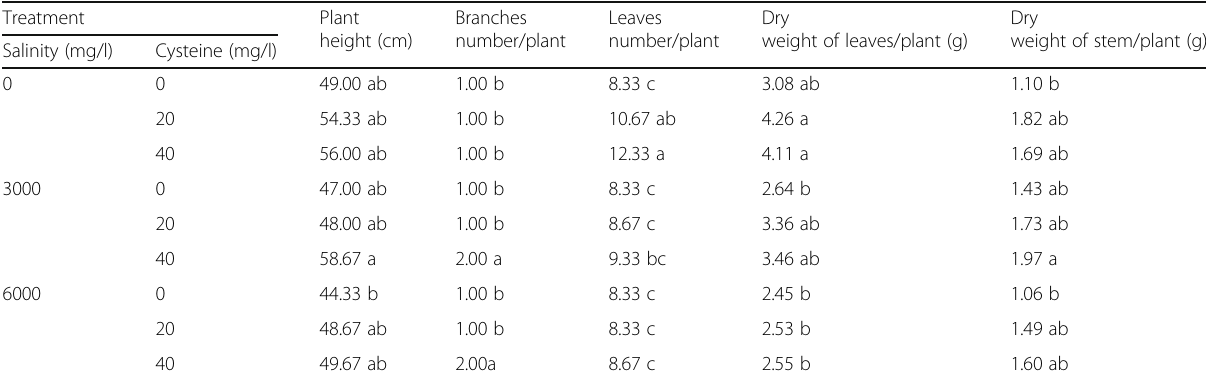
Table 1 Effect of cysteine (0, 20, and 40 mg/l) on growth criteria of soybean plant irrigated with saline water (0, 3000, and 6000 mg/ l). Results are means of two successive seasons Treatment Plant Branches Leaves height (cm) number/plant